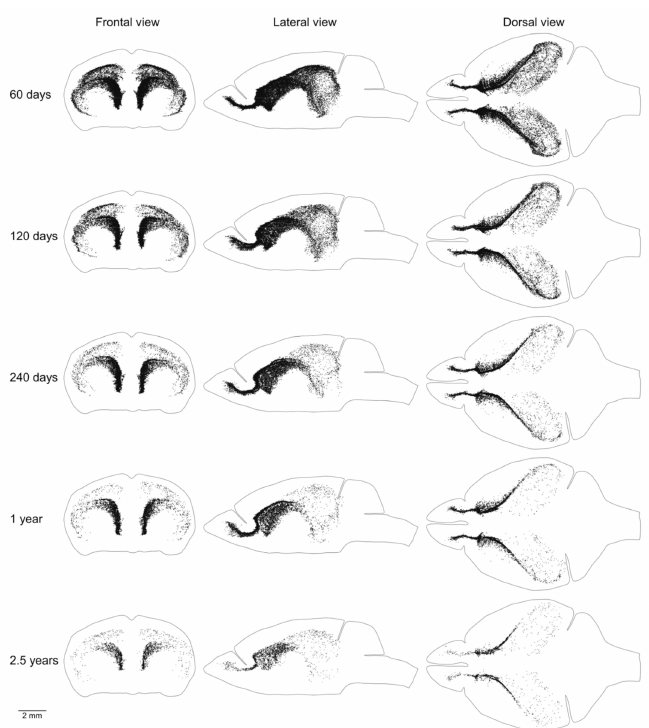
Figure 3. Distribution of proliferating cells in the main proliferative zone (MPZ). Each EdU-labeled nucleus is shown as a black dot. The scale is shown at the bottom. The brain shape is outlined with a black line. Frontal, lateral, and dorsal views of the brain are shown. Mouse age is shown on the